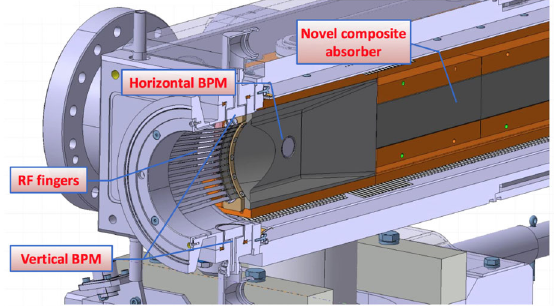
FIG. 8. 3D jaw layout of the novel secondary collimator design